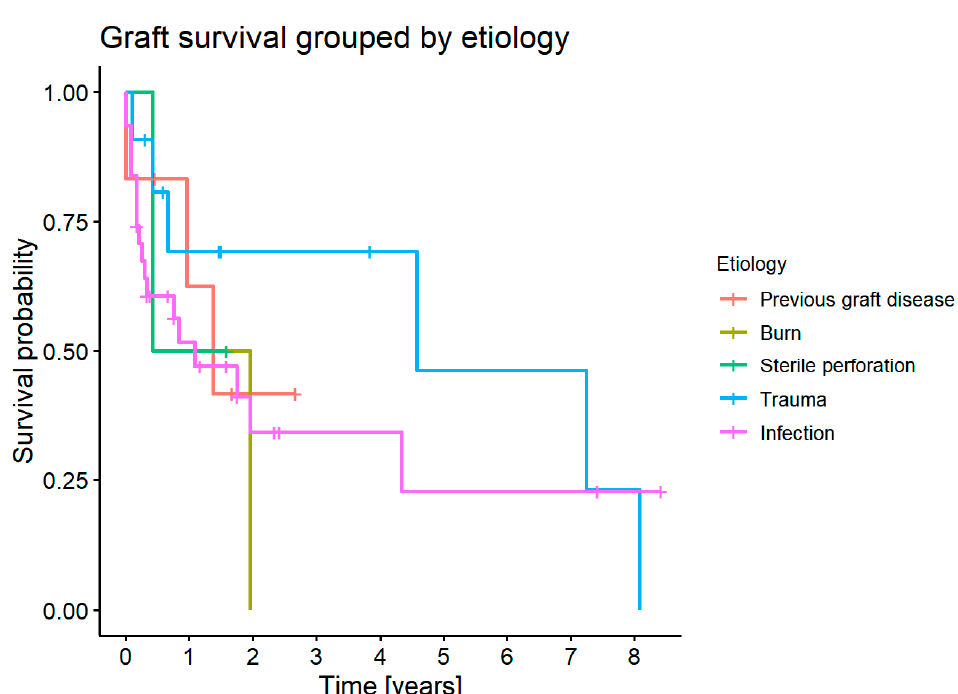
Figure 7. Survival probability for each etiology.